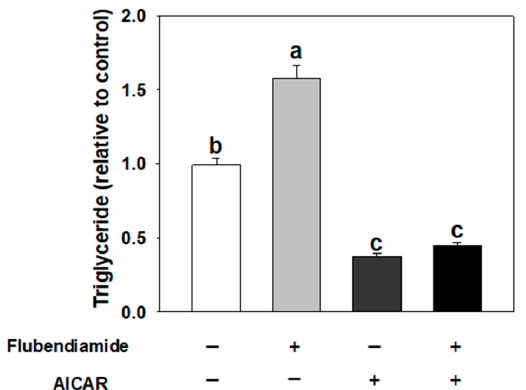
Figure 3. AICAR (5-Aminoimidazole-4-carboxamide ribonucleotide) abolished the increased fat accumulation induced by flubendiamide. Cells were treated with flubendiamide (10 μ M) or AICAR (40 μ M) for 8 days. Each value is expressed as the mean ± standard error of three separate experiments. Means with different letters were significantly different at p < 0.05 (a vs. b, a vs. c or b vs. c are significantly different).